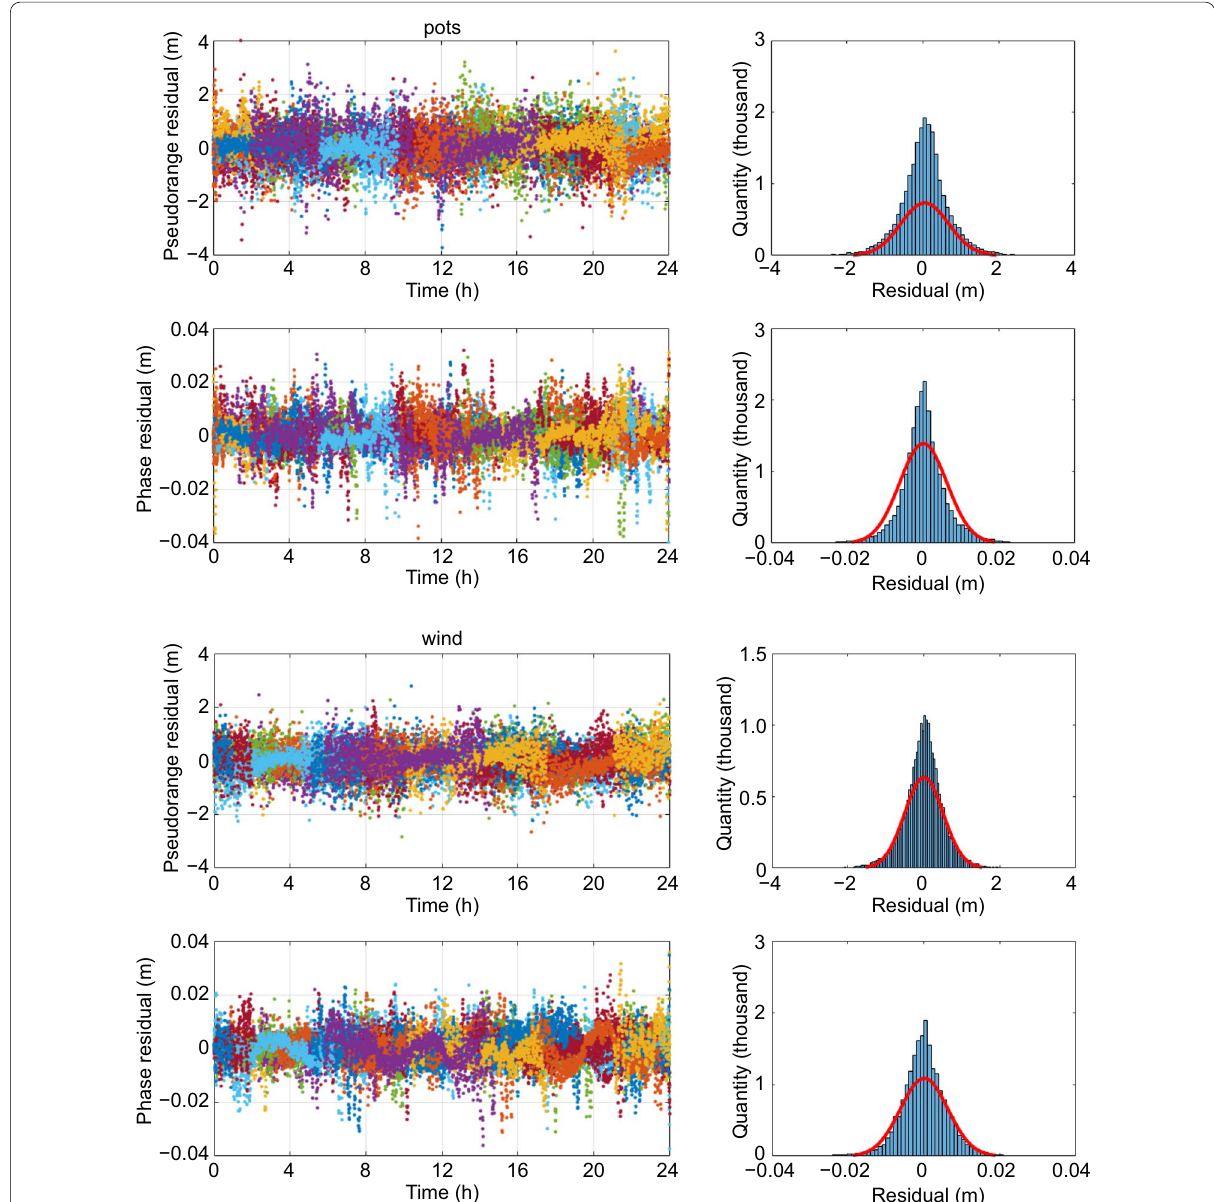
Fig. 2 Observation residuals for FF5 model at stations pots and wind (DOY 283,